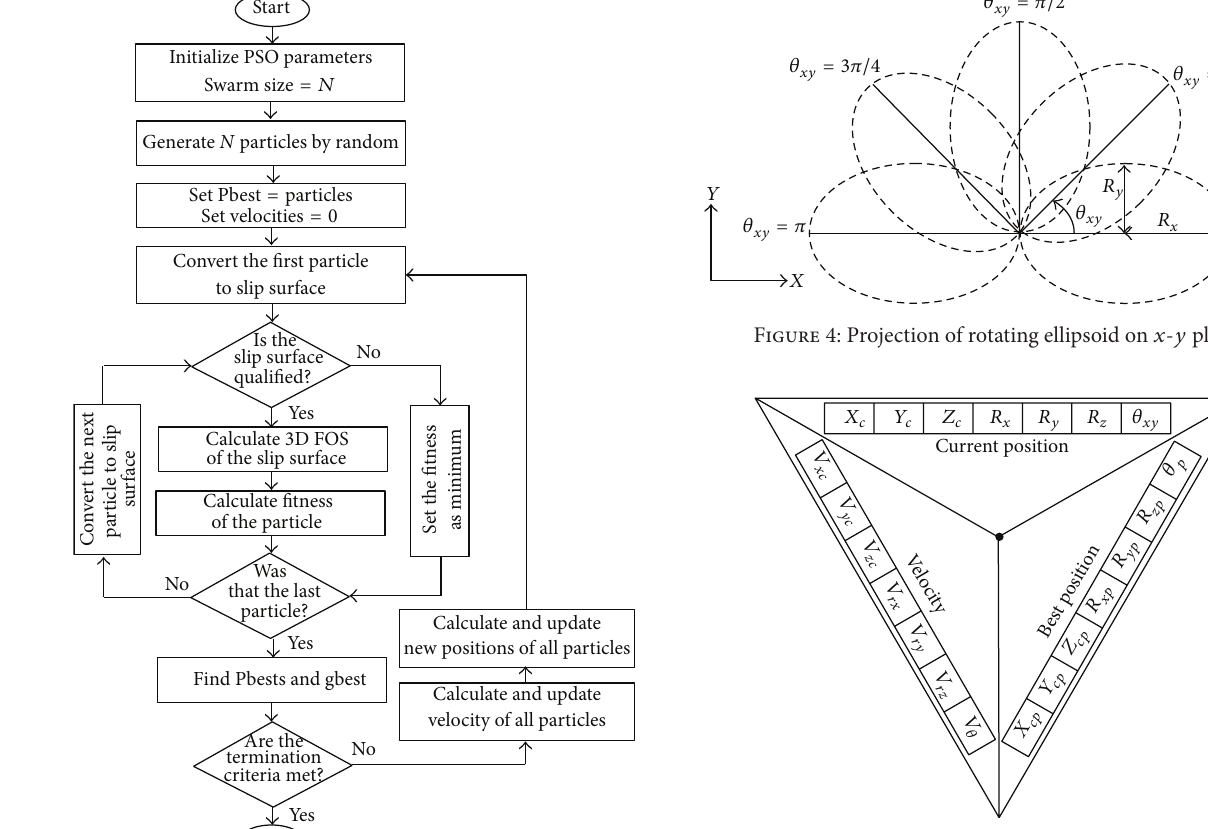
Figure 5: Schematic structures of PSO